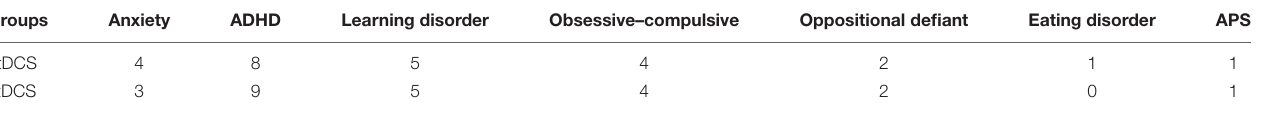
TABLE 1 | Number of comorbidities in the two groups.